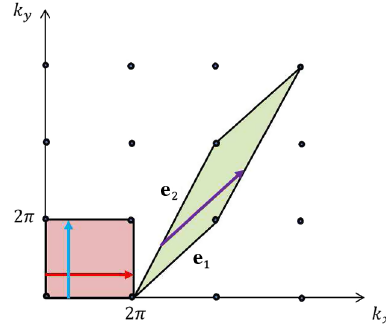
FIG. 4. Illustration of different definitions of Wannier states, which lead to different types of topological nematic states. e and e are two reciprocal vectors defining a Brillouin zone. The 2 Wannier-state basis can be constructed by taking the Fourier transform of Bloch states along one periodic direction of the Brillouin zone, which are marked by the red, blue, and purple lines with arrows. The red, blue, and purple lines correspond to topological nematic states of the types (1,0), (0,1), and (1,1), respectively (see